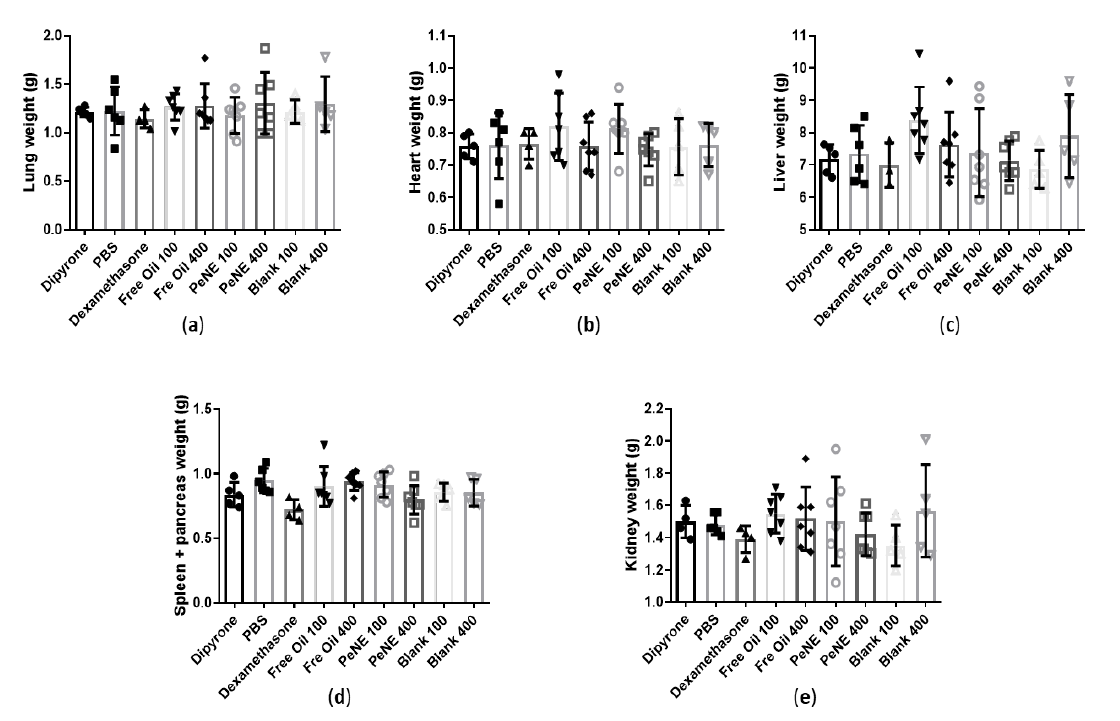
Figure 9. Evaluation of the weight of the organs of animals pre-treated with free oil (100 and 400 mg/kg/p.o.) or nanoencapsulated pequi oil (PeNE 100 and 400 mg/kg/p.o.) or the blank or control groups for 15 days. ( a ) Lung weight; ( b ) heart weight; ( c ) liver weight; ( d ) spleen and pancreas weight; ( e ) kidney weight. Statistics: ordinary one-way ANOVA. All data are presented as mean ± SD ( n = 4 – 7).